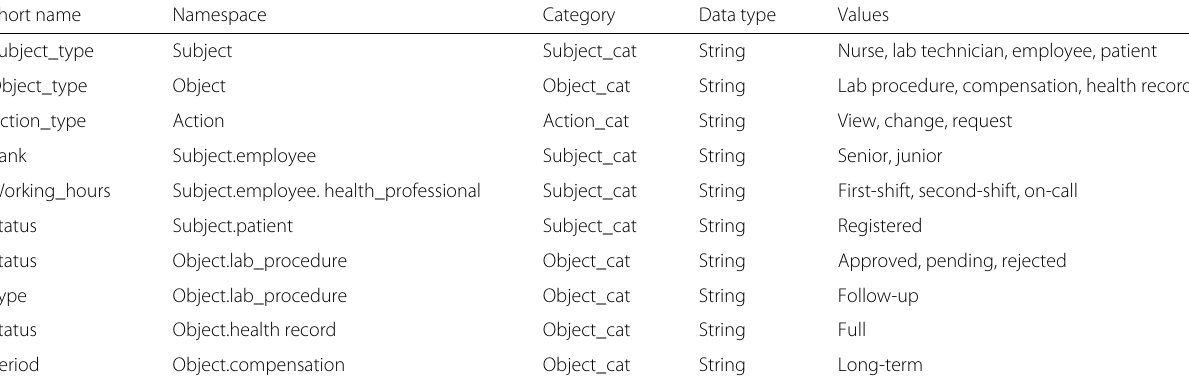
Table 1 List of attributes needed to build ABAC authorization rules to enforce policies presented in the running example (see “Running example”